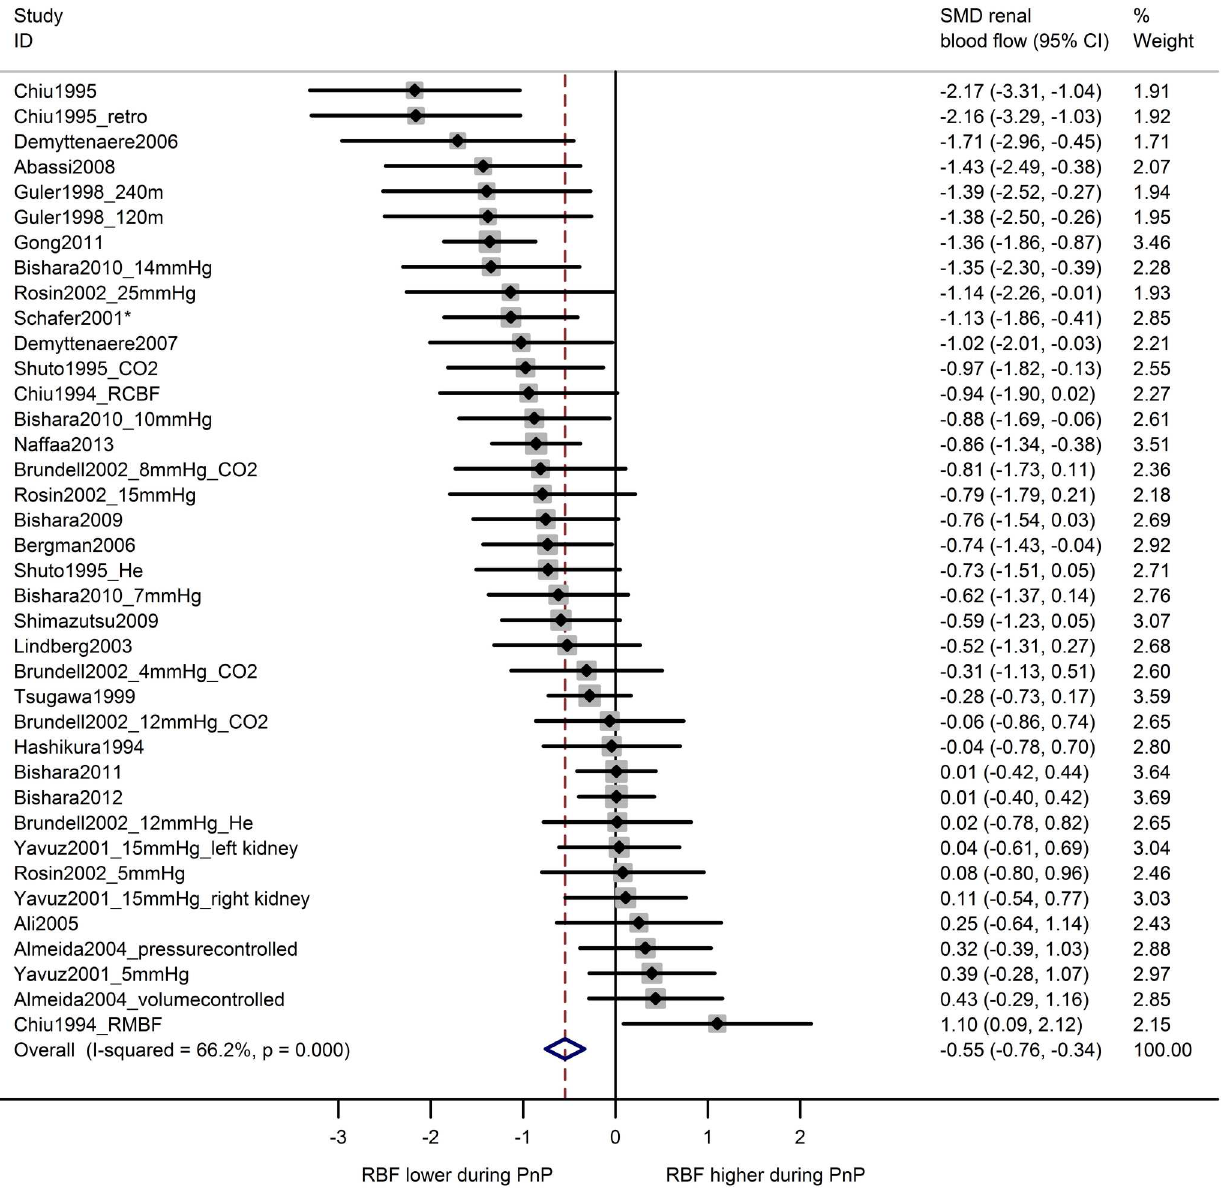
Fig 5. Renal blood flow is decreasedduring pneumoperitoneum compared to baseline. Forest plot of studies comparingrenal blood flow during pneumoperitoneumwith baselinemeasurements in the same animals. Effect size is calculated as standardized mean difference (SMD) in renal blood flow, and corresponding 95% confidenceintervals (95%CI). Weights are from random effects analysis. * baselinemeasurements during laparotomy; retro = retroperitoneum applied; m = duration in minutes of PnP at time of measurement; mmHg = pressure in experimental group; CO2 = insufflation with carbon dioxide; He = insufflation with helium; RCBF = renal cortical blood flow; RMBF = renal medullaryblood